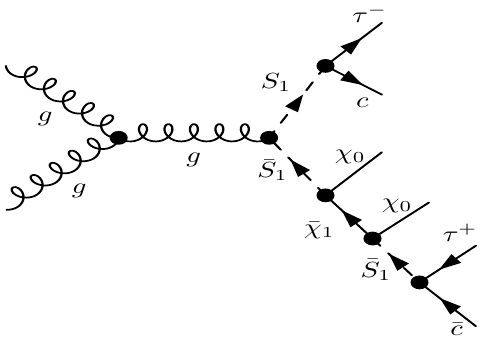
Figure 9 . Example of Feynman diagram illustrating the QCD-driven leptoquark pair production and decay and leading to the cτ plus MET